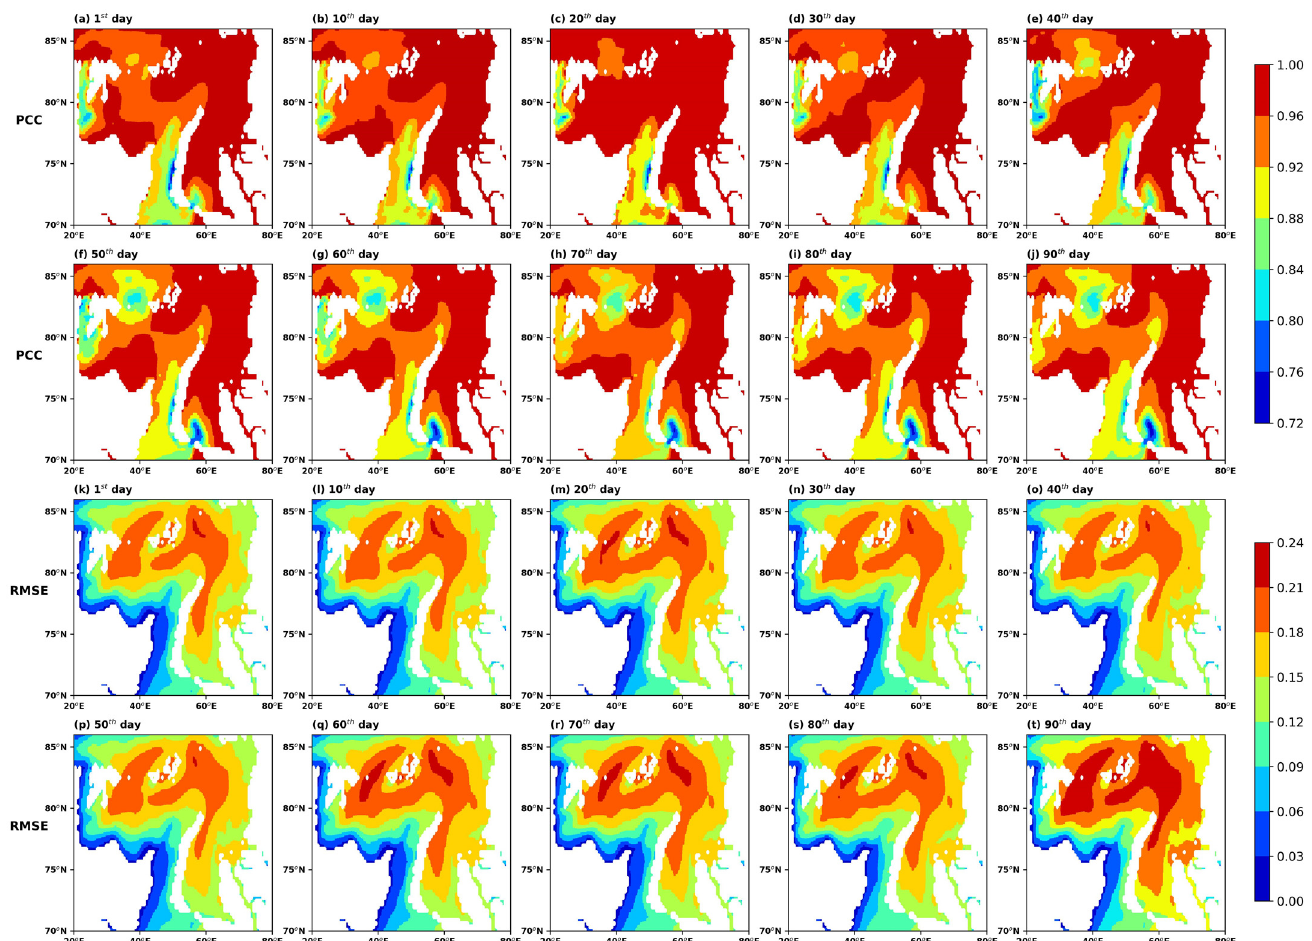
Figure 7. Spatial distribution of Pearson correlation coefficient (PCC) ( a – j ) and root-mean-square error (RMSE) ( k – t ) of sea ice concentration (SIC) for the EOF–LSTM–DNN model. Calculated from daily forecasts over a 100-day range for 2017–2019.